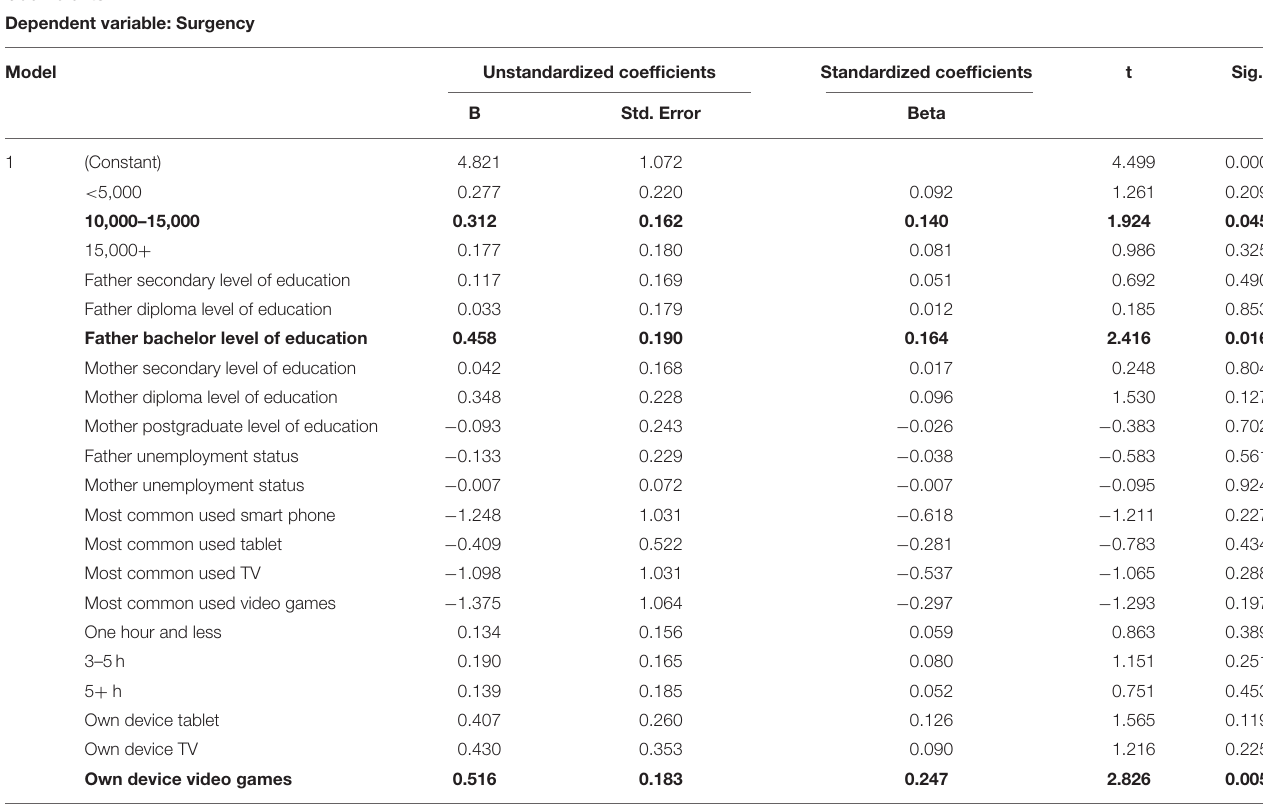
TABLE 5 | Regression coefficient table showing the strength of association between technology and demography variables and “Surgency.” Coefficients